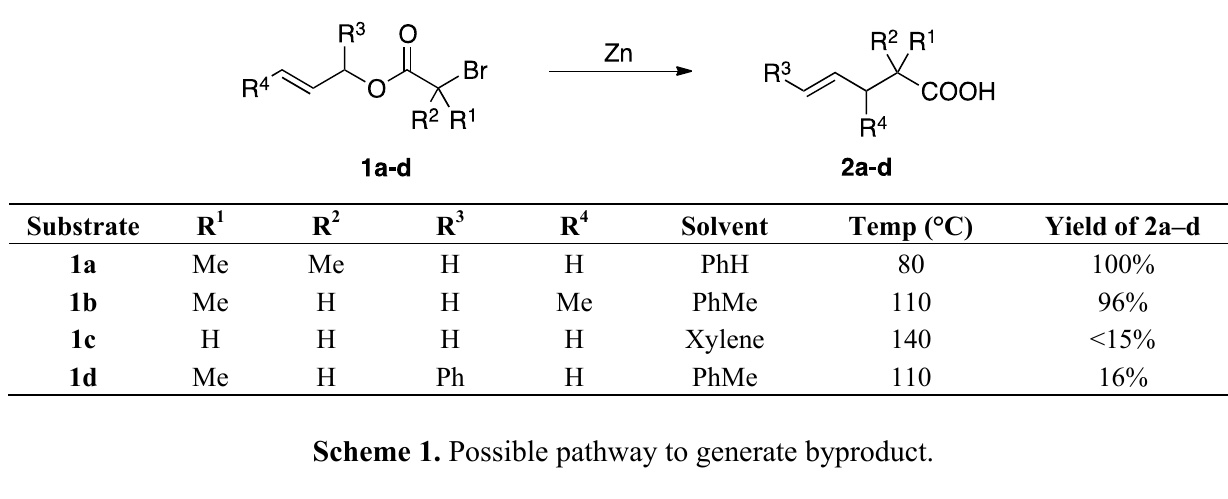
Table 1. Baldwin and Walker’s pioneering work of the Reformatsky-Claisen